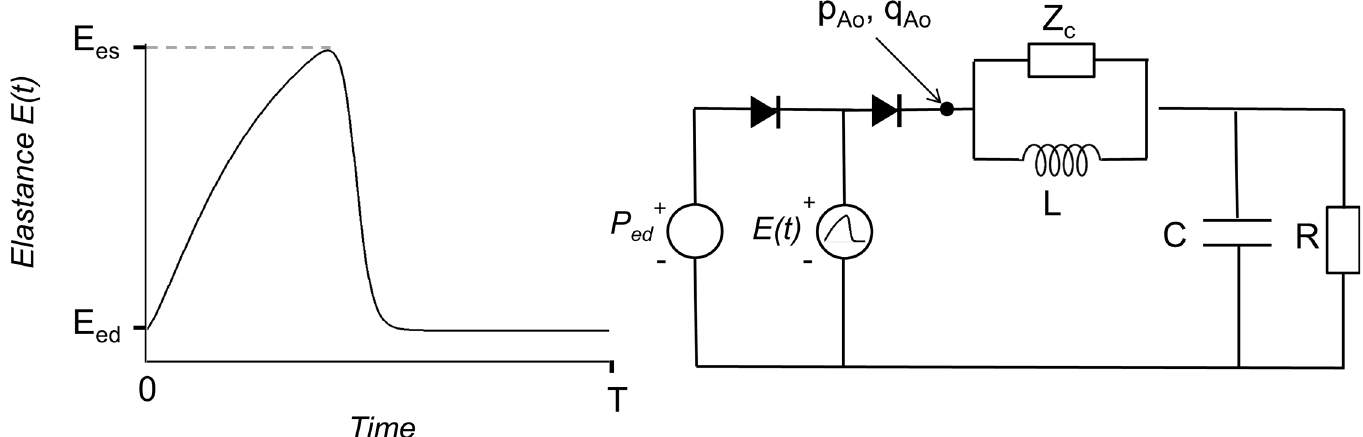
Fig 1. Schematic representation of the time-varying elastance model E(t) and the four-element Windkessel model. E(t) varies from its end-diastolic value (Eed) to its end-systolic value (Ees) during the heart period (T). The arterial model includes characteristic impedance (Zc), inertance (L), total arterial compliance (C) and vascular resistance (R). Voltage and current at the beginning of the Windkessel model represent aortic pressure (pAo) and flow (qAo),